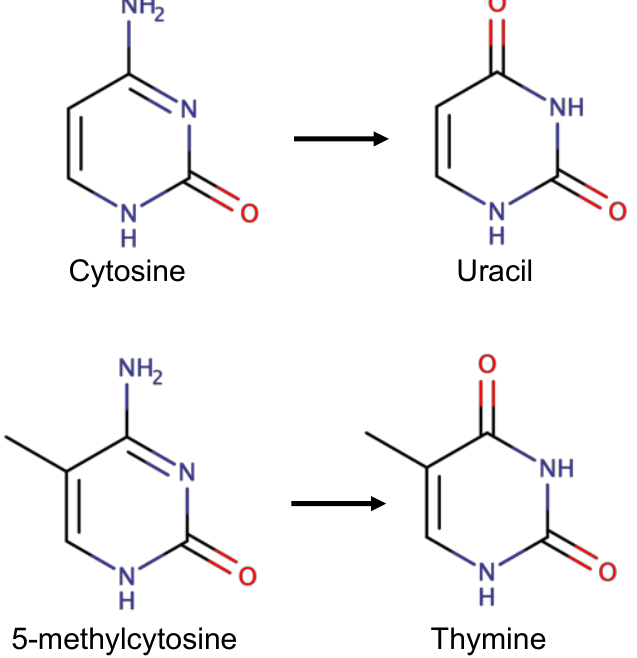
Figure 6. Deamidation of cytosine to uracil and 5-methylcytosine to thymine. The exocyclic amine of cytosine can be spontaneously deamidated to give uracil and the excocyclic nitrogen of 5-methylcytosine can be spontaneously deamidated to give thymine. Uracil is removed from DNA by uracil-DNA glycosylase while the G:T base-pair resulting from spontaneous deamidation of 5-methylcytosine can be removed by thymine DNA glycosylase (Figure drawn with Marvin-Sketch, from ChemAxon, https://www.chemaxon.com).